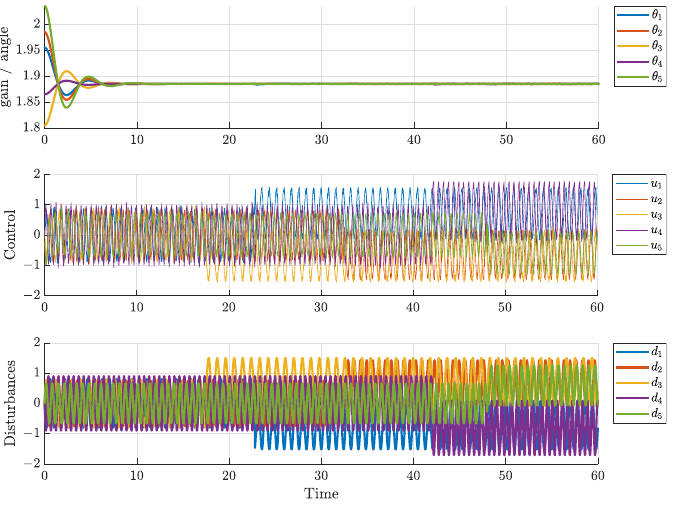
Figure 5. Angle variations, control, and disturbances under